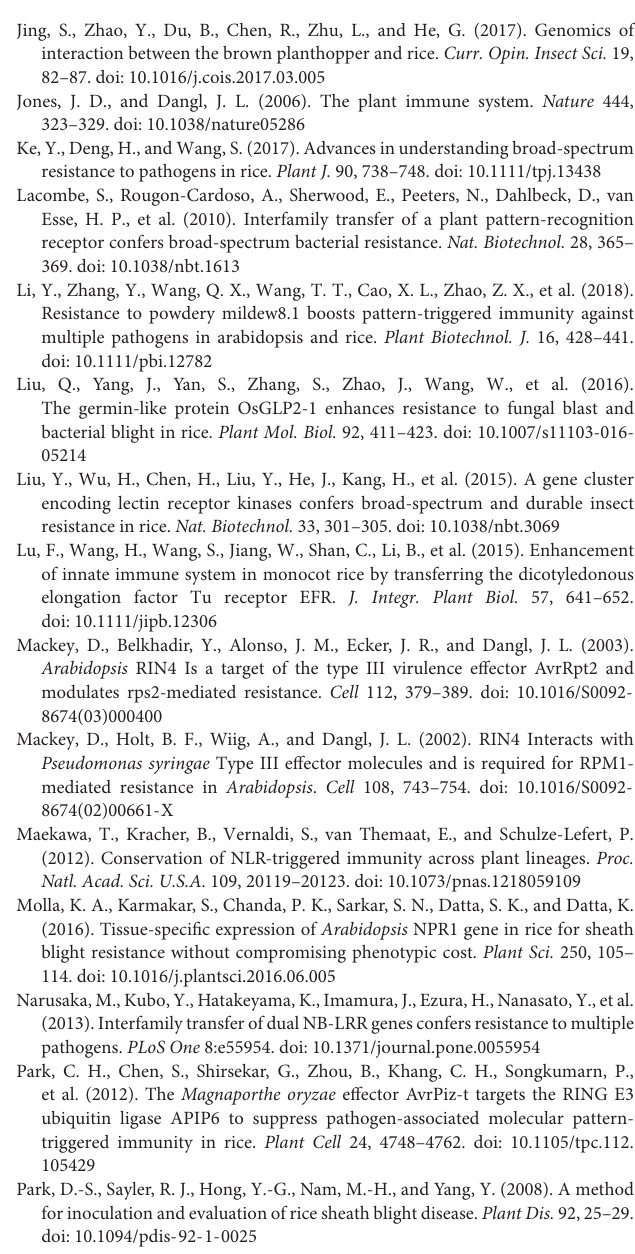
FIGURE S2 | Disease resistance assays with detached leaves of the AtRPS2 , AtRPM1 ( D505V ) transgenic plants and Nipponbare. (A) Detached leaves of 4 weeks old plants were lightly wounded with an ear punch, and 8 µ L of spore suspension (5 × 10 5 /mL) of M. oryzae isolate was added to the wound sites. Pictures were taken at 7 dpi, bars = 2 cm. (B,C) Lesion length and fungal growth were measured at 7 dpi. Data are shown as means ± SD ( n = 20). Asterisks denote significant differences (one way ANOVA, ∗∗∗ P < 0.001). Similar results were obtained in three independent experiments. FIGURE S3 | GO analysis of differentially expressed genes between AtRPS2 transgenic plants and Nipponbare. FIGURE S4 | GO analysis of differentially expressed genes between AtRPM1 ( D505V ) transgenic plants and Nipponbare.